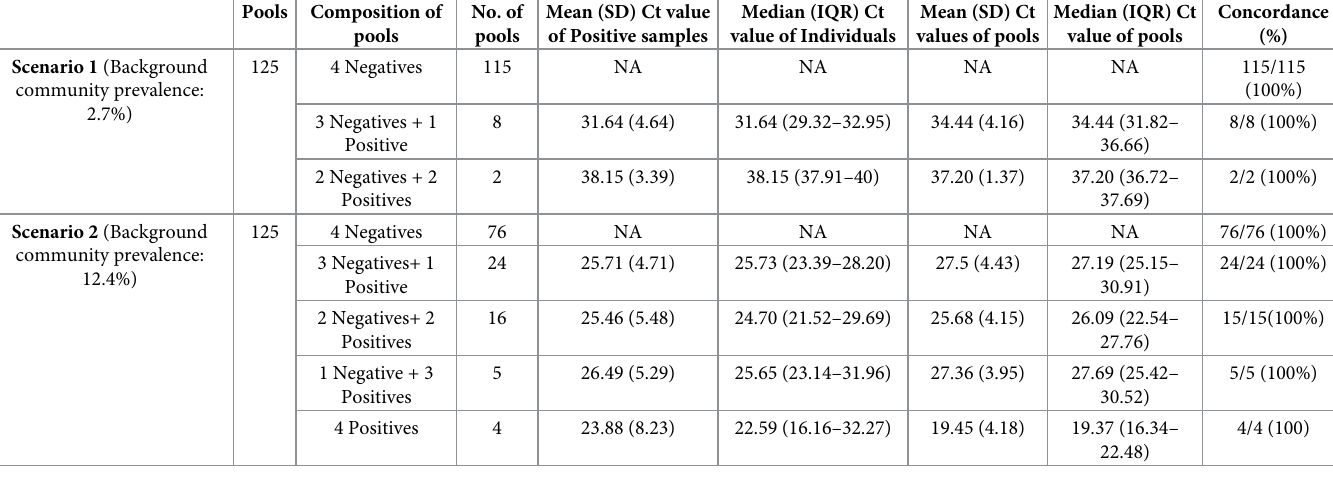
Table 2. Concordance between individualized and consecutive pooling strategies of 4-sample pools in 2 different prevalence settings. Pools Composition of